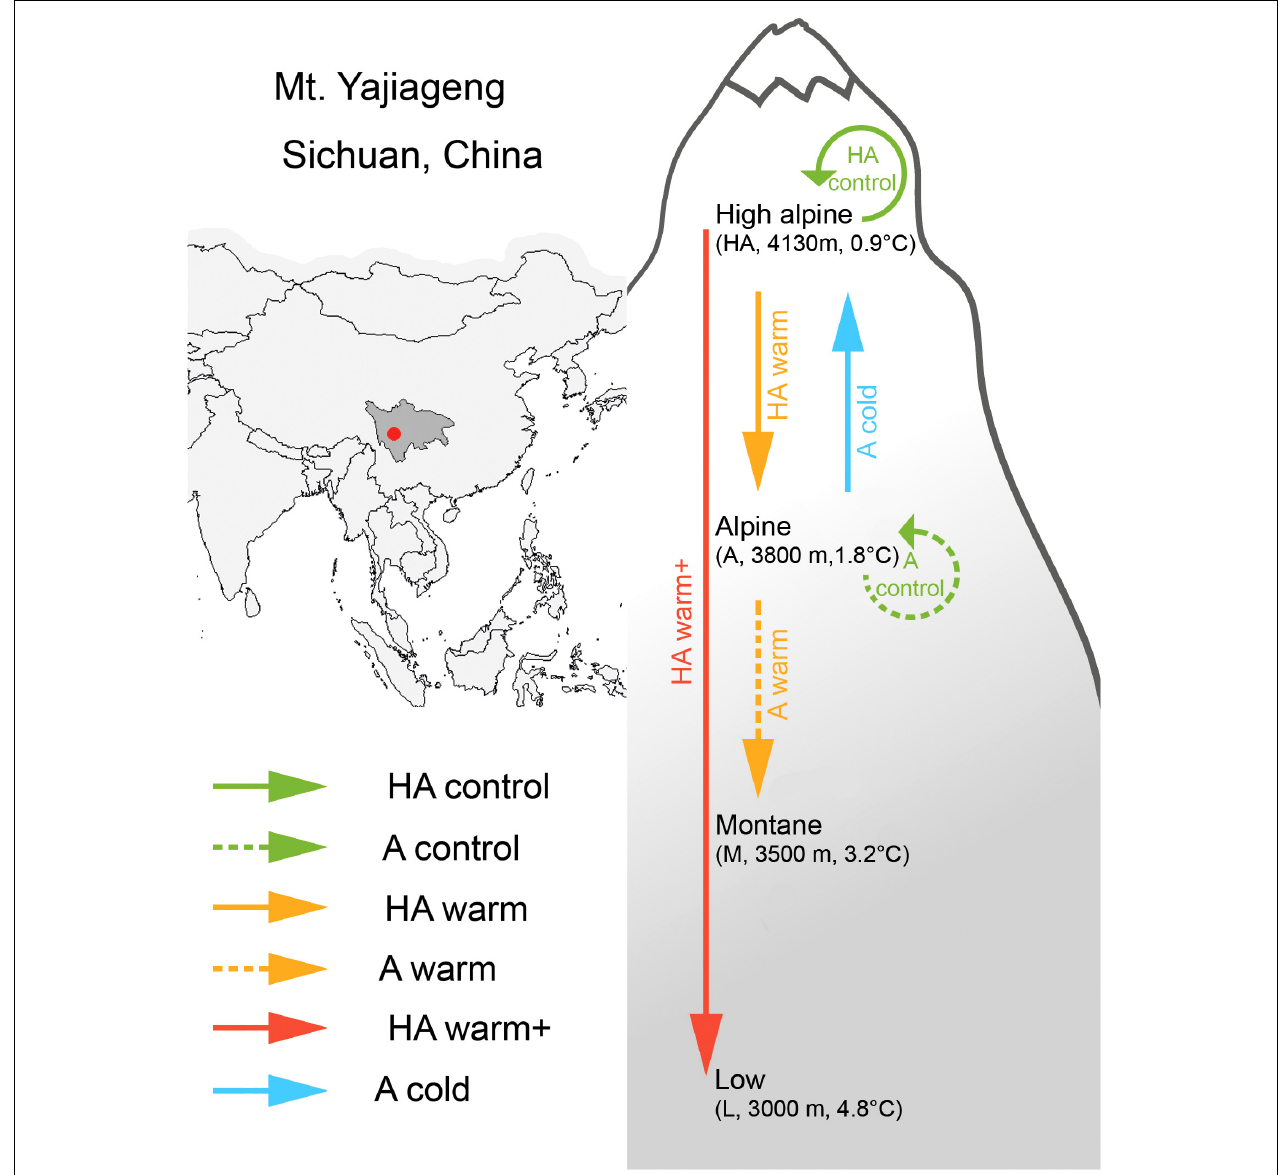
FIGURE 1 | Geographic location and experimental setup for the transplant experiment. Arrows indicate direction of transplantation; for each of the four sites altitude and mean annual temperature are